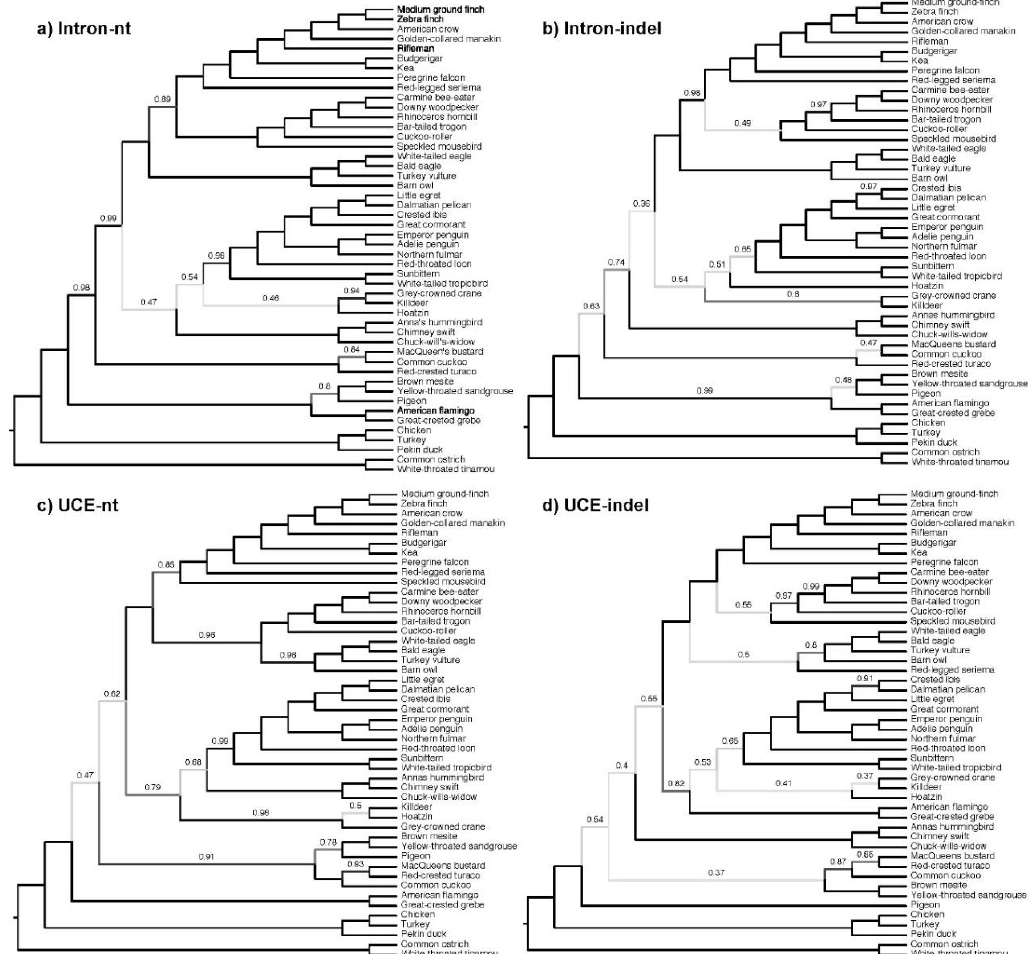
Figure 8. ASTRAL trees using intron ( a , b ) and UCE ( c , d ) loci with gene trees computed using nt ( a , c ) or indels ( b , d ) and branches with up to 5% BS contracted. Branch labels show localPP and those without a designation have a localPP of 1.0. Shades of grade correspond to the support value.